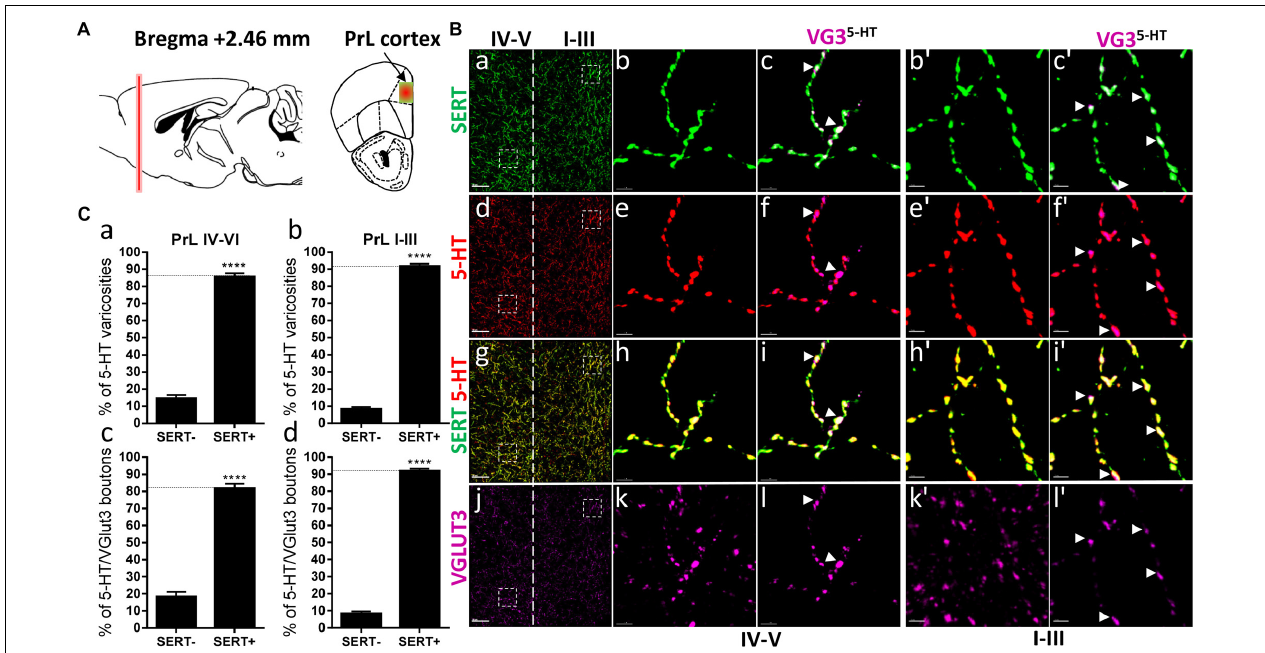
FIGURE 1 | Distribution of VGLUT3 + boutons within 5-HT + and SERT + axons in the prelimbic cortex. (A) Schematic drawing showing the location of the acquired micrographs. Prelimbic (PrL) cortex mosaic images of layer I–V were acquired at bregma + 2.46 ± 0.2 mm (red vertical line) in the dorsal half of the medial cortex (yellow/red square). (B) Micrograph showing the distribution of the SERT (green, a–c,b’,c’ ), 5-HT (red, d–f; e’,f’ ), SERT (green) + 5-HT (red) (g–i, h’,i’) , and VGLUT3 (magenta, j–l, k’,l’ ). Left panel shows lower magnification ( a,d,g,j ). Scale bar: 50 µ m. Middle panel shows higher magnification of the white dash box for layers IV–V ( b,c,e,f,h,i,k,l ) and right panel shows higher magnification white dash box for layers I–III (b’,c’,e’,f’,h’,i’,k’,l’) . Scale bar: 2 µ m. The panel labeled VG3 − 5 − HT shows the VGLUT3 boutons co-labeled with SERT (c,c’) , 5-HT (f,f’) , and SERT + 5-HT (i,i’) . VGLUT3 puncta located within 5-HT varicosities were isolated using Imaris (l,l’) . Arrowheads show 5-HT varicosities collocated with SERT and VGLUT3 (c,c’,f,f’,i,i’,l,l’) . (C: a,b) Quantification of the proportion of 5-HT varicosities not co-labeled (SERT - ) and co-labeled (SERT + ) with SERT in the upper (I–III) or deeper (IV,V) layers of the PrL, showing a great majority of 5-HT varicosities co-labeled with SERT. (c,d) Quantification of the proportion of 5-HT + /VGLUT3 + not co-labeled (SERT - ) and co-labeled (SERT + ) with SERT in the upper (I–III) or deeper (IV,V) layers of the PrL, showing a great majority of 5-HT + /VGLUT3 + varicosities co-labeled with SERT ( t -test, ∗∗∗∗ : p <